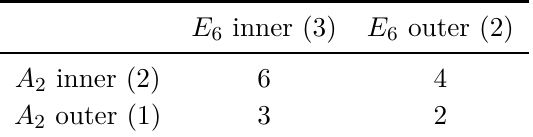
Table 4 . There are 15 automorphisms of the A 2 × E 6 Lie algebra of order less than or equal to 2. The row and column labels denote the origin of the A 2 × E 6 automorphisms. For example, there are 4 Z 2 actions on A 2 × E 6 which come from one of the (2) inner actions on A 2 times one of the (2) outer actions on E 6